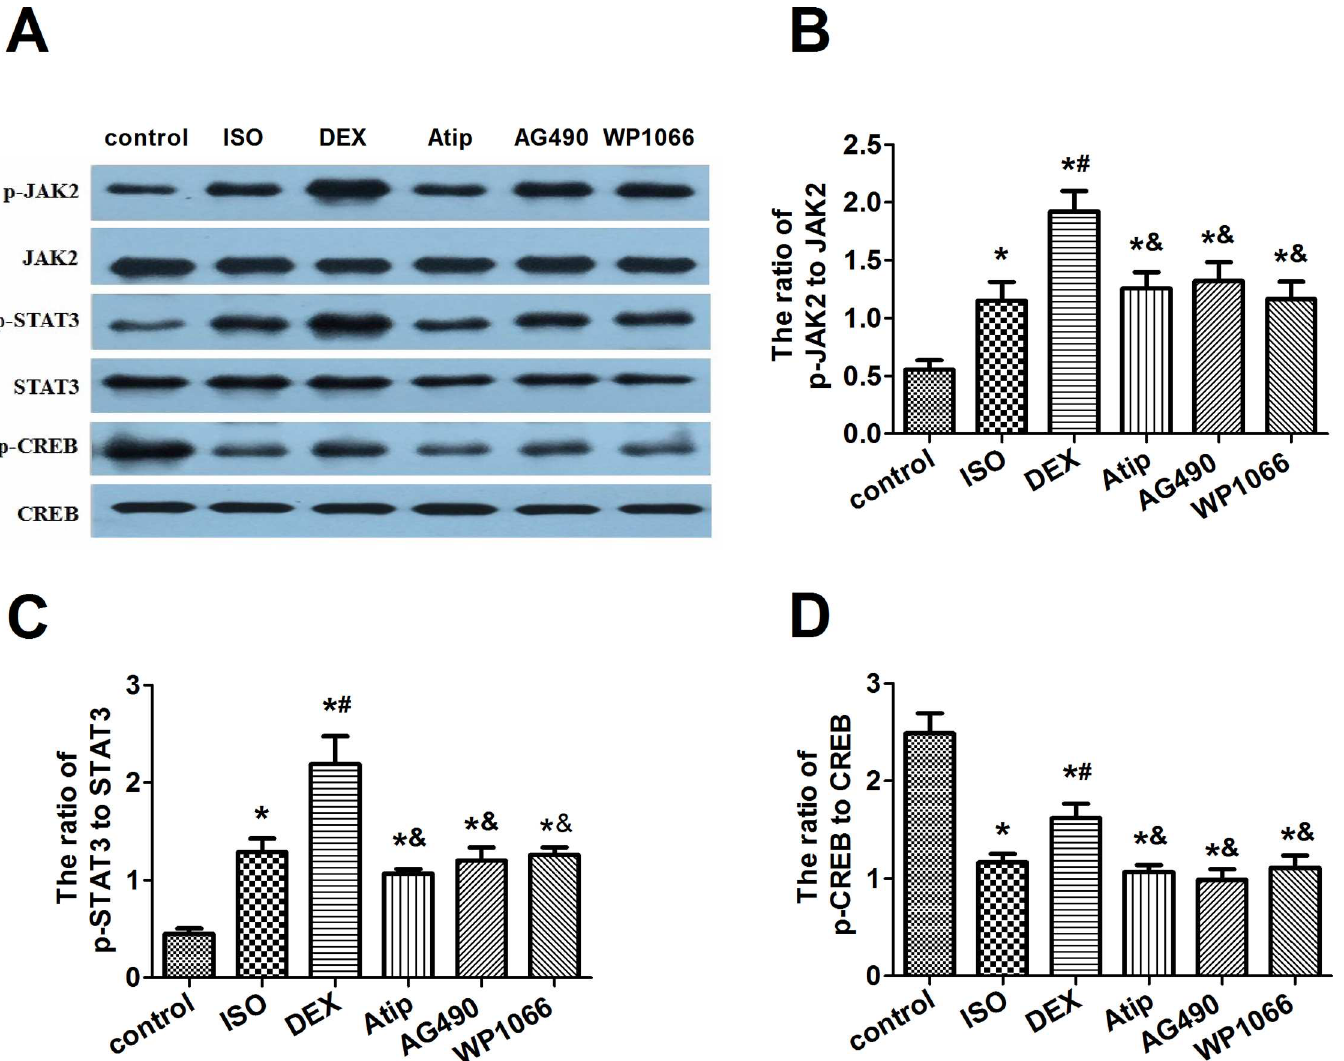
Fig 4. Effects of dexmedetomidine on p-CREB levels and JAK2/STAT3 pathway activation in hippocampus. Representative Western blots (A) showinglevels of JAK2, p-JAK2, STAT3, p-STAT3, CREB, and p-CREB in hippocampus at 19d after animals were treated as describedin Fig 2. Densitometry was used to determine ratios of the levels of p-JAK2 to JAK2 (B), p-STAT3 to STAT3 (C), and p-CREB to CREB (D). Data are represented as mean ± SD (n = 8). * P < 0.05 vs. control group; # P < 0.05 vs. ISO group; & P < 0.05 vs. DEX